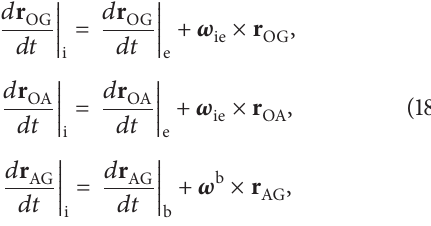
Our system, Φ = 0 ∘ , RMSE = 0.85 ∘ Our system, Φ = 20 ∘ , RMSE = 0.84 ∘ HMR 3300 , Φ = 0 ∘ , RMSE = 1.37 ∘ HMR 3300 , Φ = 20 ∘ , RMSE = 3.45 ∘ Figure 8: Static precision test of yaw